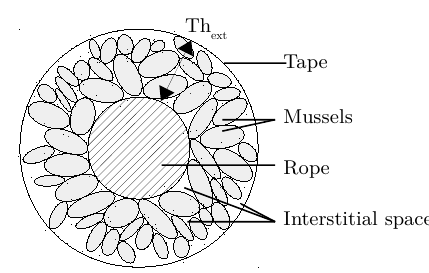
Figure 13. Cross-section of a mussels cluster on a rope, revealing interstitial spaces.